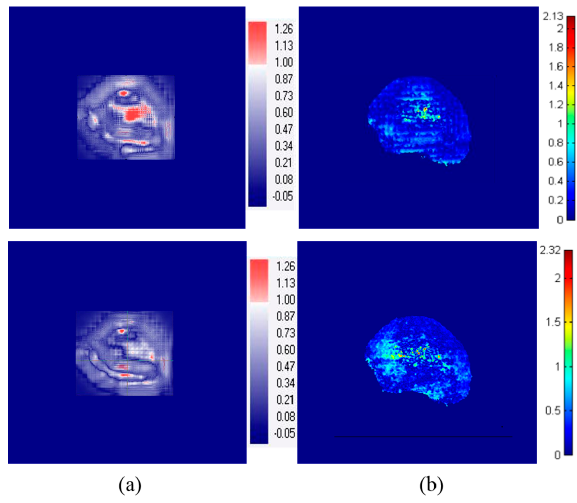
Figure 6. Example of dose comparison using the gamma evaluation method for an irregularly-shaped field. (Field 5 in Table 2). ( a ) MatriXX vs. FOR; ( b ) EBT3 film vs. FORS. The number denotes the gamma index.